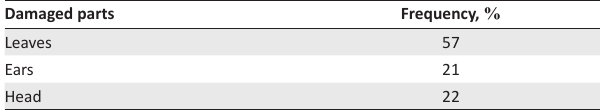
TABLE 2: Fall armyworm damage on maize